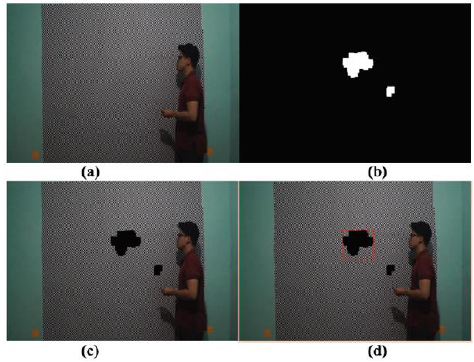
Figure 9. Peak Density of Cigarette Smoke in an Indoor Environment at 2.8 seconds (70 th Frame) (a) raw video frame (b) binarized video frame (c) masked video frame (d) the masked